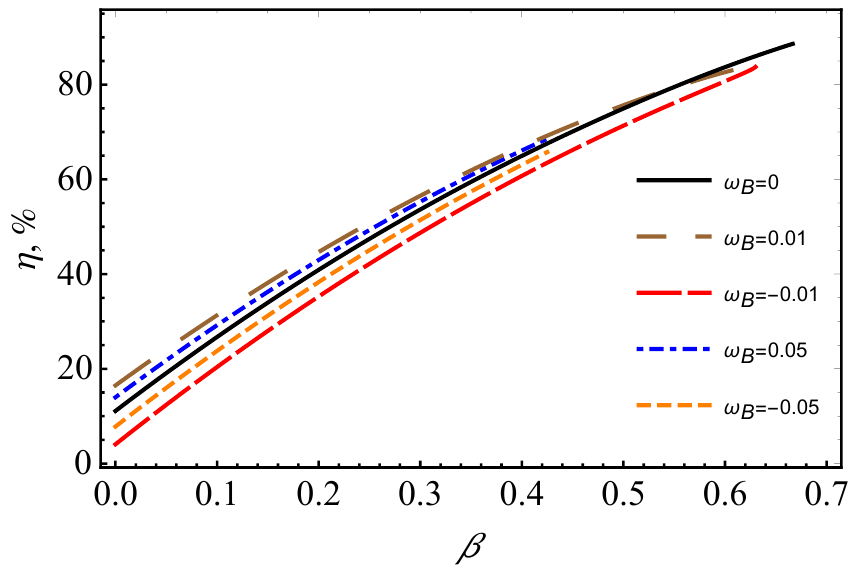
Figure 5. Dependence of the energy efficiency on the magnetic-coupling parameter β for different values of the parameter ω